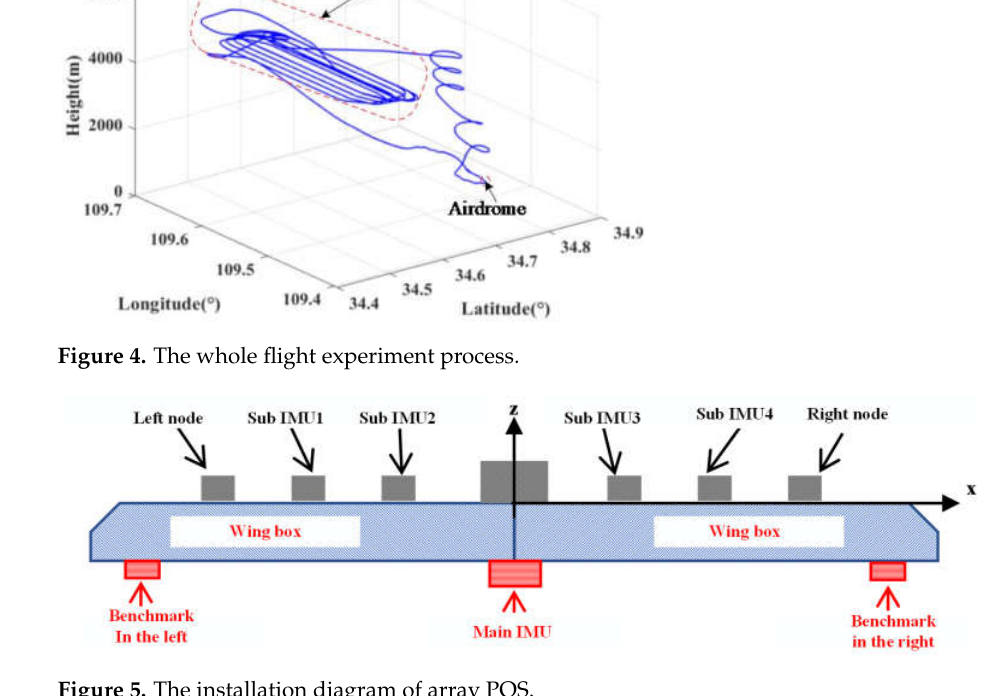
Figure 5. The installation diagram of array POS. Table 2. The simulation parameter settings of each sub-IMU.